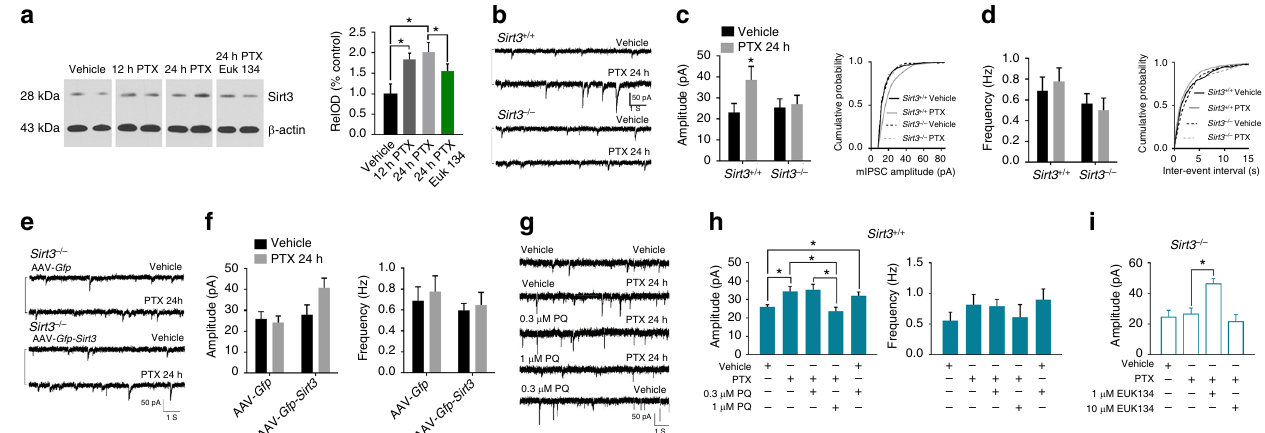
Fig. 4 SIRT3 is required for GABAergic synaptic scaling. a Immunoblots (left) showing relative levels of SIRT3 protein in cultured WT hippocampal neurons exposed to the indicated treatments for 24 h; 100 μ M picrotoxin (PTX) for 12 h; 100 μ M PTX for 24 h; 10 μ M EUK-134 plus 100 μ M PTX for 24 h. (* P < 0.05). b Whole-cell recordings of mIPSCs in cultured hippocampal neurons from Sirt3 + / + and Sirt3 – / – mice that had been treated with vehicle or 100 μ M PTX for 24 h. c Amplitudes of mIPSCs (left) and a plot of cumulative event probability as a function of mIPSC amplitude (right) in Sirt3 + / + and Sirt3 – / – neurons treated for 24 h with vehicle or PTX (15 neurons/group). d mIPSC frequency (left) and a plot of cumulative event probability as a function of mIPSC inter-event interval (right) in Sirt3 + / + and Sirt3 – / – neurons treated for 24 h with vehicle or PTX (15 neurons/group). * P < 0.05 compared to the values for each of the other 3 groups. e Whole-cell recordings of miniature postsynaptic currents (mIPSCs) in cultured hippocampal neurons from Sirt3 – / – mice that had been infected with AAV vectors to overexpress either SIRT3 and GFP, or GFP alone; 6 days after infection, cultures were treated with vehicle or 100 μ M PTX for 24 h. f Amplitudes (left) and frequencies (right) of mIPSCs in Sirt3 – / – neurons in the four different groups (15 neurons/group). * P < 0.05 compared to the values for each of the other 3 groups. g Whole-cell recordings of miniature postsynaptic currents (mIPSCs) in cultured hippocampal neurons from Sirt3 + / + mice that had been treated for 24 h with vehicle, 100 μ M PTX, 0.3 μ M paraquat (PQ) plus PTX, 1.0 μ M PQ plus PTX, or 0.3 μ M PQ plus vehicle. h mIPSC amplitudes (left) and frequencies (right) in Sirt3 + / + neurons in the indicated treatment groups (24 h treatment; 12 neurons/group). * P < 0.05. i Results of measurements of mIPSC amplitudes in Sirt3 -/- neurons in the indicated treatment groups (24 h treatment; 12 neurons/group). * P < 0.05. All error bars are the SEM. All statistical comparisons for data in this fi gure were performed using ANOVA and Newman – Keuls post hoc tests for pairwise comparisons. Source data for all graphs in this fi gure are provided in supplemental Source Data fi